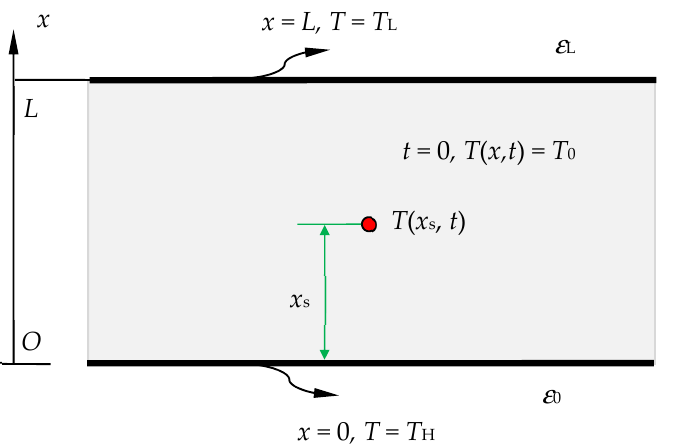
Figure 1. Schematic of coupled conductive and radiative heat transfer in an absorbing and scattering slab.